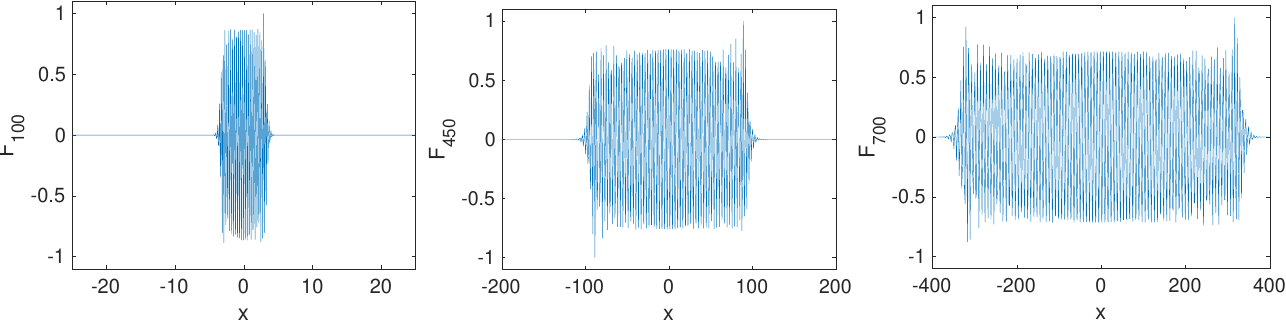
Figure 5. The real part of three sample eigenfunctions is depicted. These eigenfunctions have eigenvalues with “spurious” real parts Re ( λ 100 ) ≈ 10 − 9 , Re ( λ 450 ) ≈ 10 − 8 , and Re ( λ 700 ) ≈ 10 − 6 respectively. These values were computed with a = 3.9, N = 1024, and L =